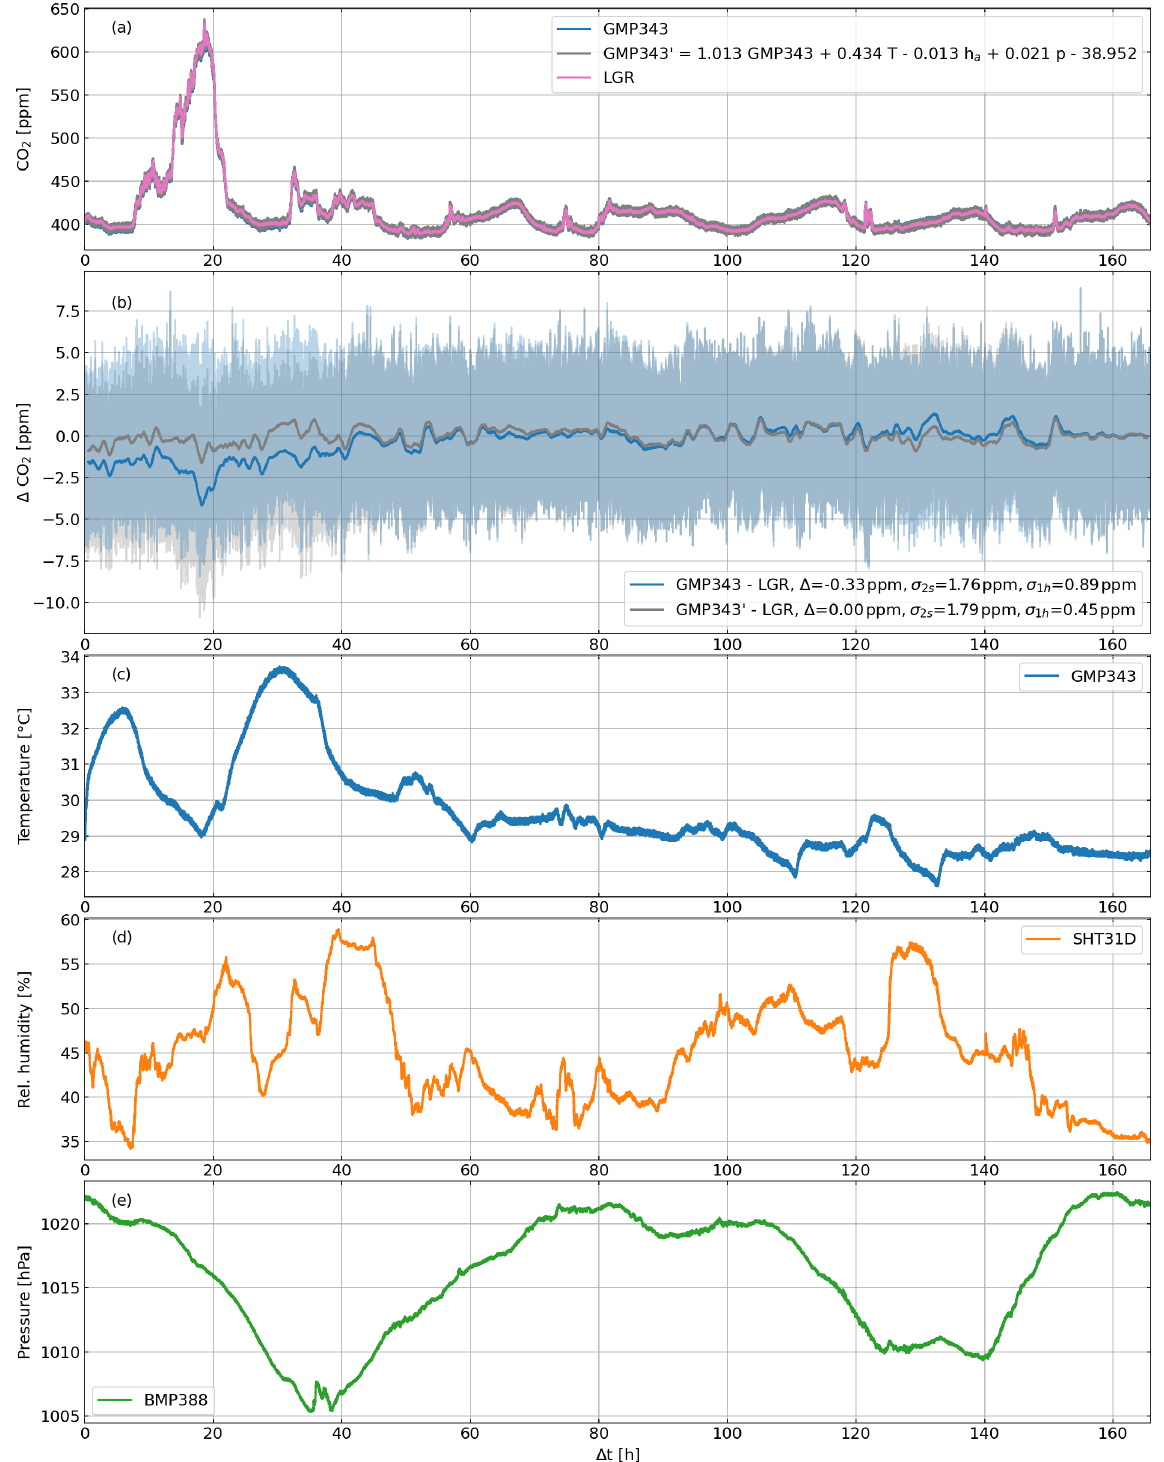
Figure 2. (a) CO 2 concentration measured in the laboratory with the Vaisala GMP343 CO 2 sonde with and without linear correction (Eq. 1) as well as highly accurate reference measurements performed with an ABB LGR-ICOS ultra-portable greenhouse gas analyzer. (b) Difference between the Vaisala GMP343 CO 2 (with and without linear correction) and the reference measurements. Pale colors represent instantaneous differences and intense colors 1h running averages. (c) Temperature measured with the Vaisala GMP343. (d) Relative humidity measured with a Sensirion SHT31-DIS sensor. (e) Pressure measured with a Bosch BMP388 sensor.